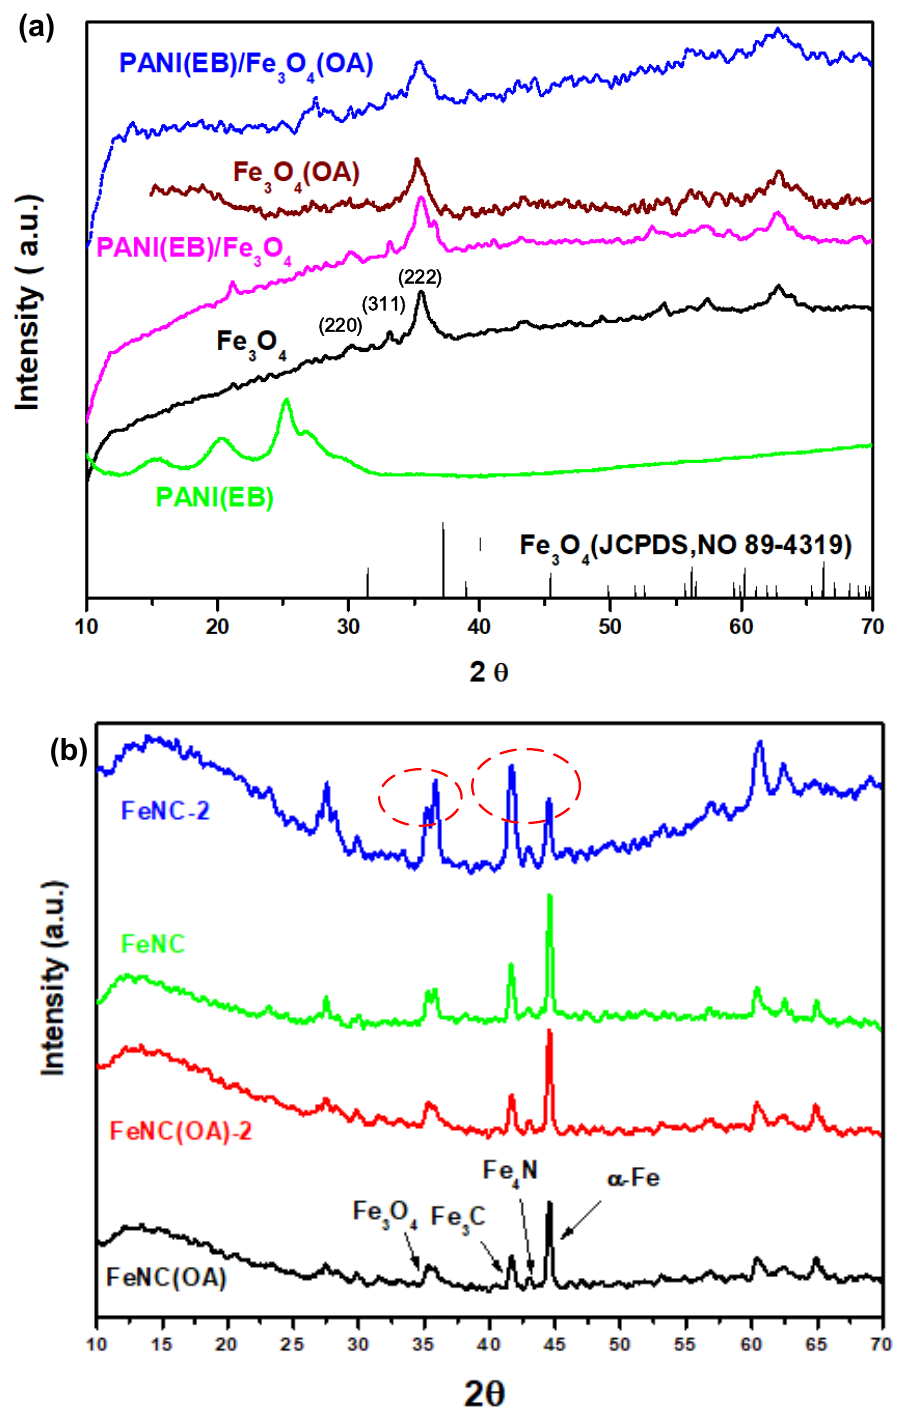
Figure 7. X-ray diffraction patterns of ( a ) PANI and iron compounds before calcination ( b ) iron compounds after calcination.